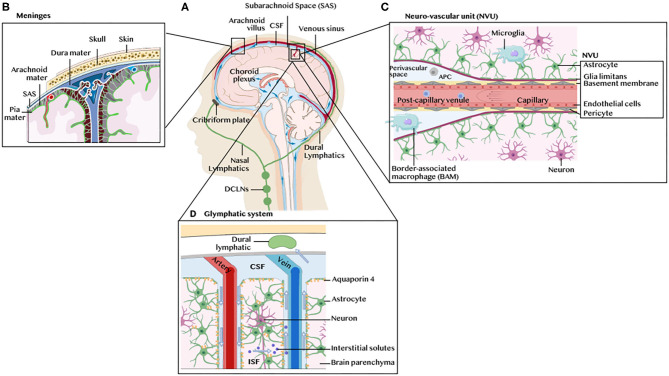
Architecture of the CNS immune system. (A) Schematic illustration of the human brain anatomy namely the brain parenchyma, choroid plexus, ventricles, cerebrospinal fluid (CSF), meninges, dural and nasal lymphatics and the deep cervical lymph nodes (DCLNs). (B) The meninges. These are three membranes that envelop the brain, namely the dura mater, the arachnoid membrane and the pia mater. (C) The neurovascular unit (NVU), blood brain barrier (BBB) and perivascular space. The glia limitans formed by astrocytes end feet ensheath the capillary basement membrane and its pericytes. The perivascular space contains microglia-like perivascular macrophages also dubbed border-associated macrophages (BAMs) and antigen-presenting cells (APC). Microglia are found in the brain parenchyma. (D) The glymphatic system. The CSF enters the brain parenchyma through aquaporin 4, water channels on the end-feet of astrocytes surrounding the vasculature, and communicates with the interstitial fluid (ISF) carrying solutes and small antigens through the glymphatic system, a network of perivascular channels formed by astroglia for waste elimination.